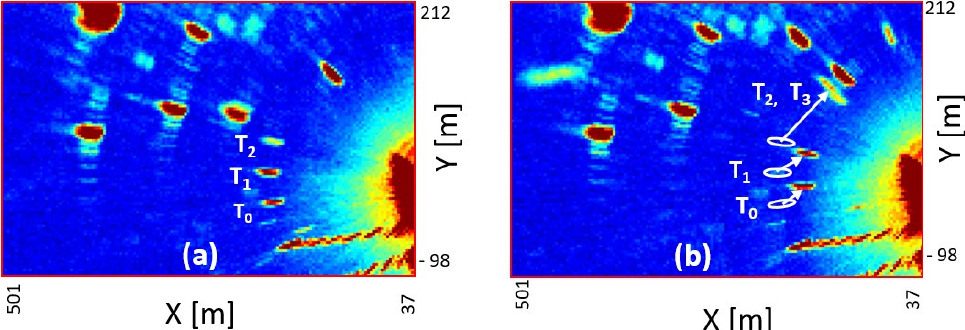
Figure 13. Movements of the targets within the study area related to the first release. ( a ) Beginning of the first release of the target; ( b ) before recovery of the target.